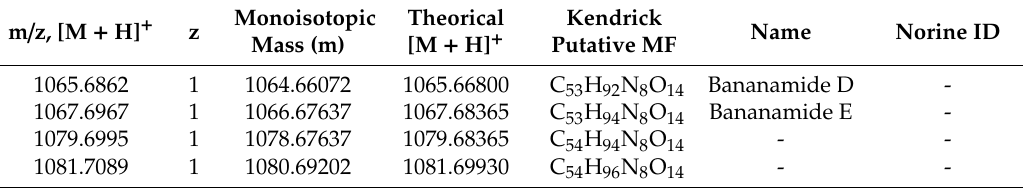
Table 1. [M + H] + values extracted from HRMS-spectrum and their corresponding molecular formula (MF) assigns using Kendrick Formula Predictor (https: // bioinfo.cristal.univ-lille.fr / kendrick-webapp / ). Monoisotopic Theorical Kendrick m / z, [M + H] + z Name Norine ID Mass (m) [M + H] + Putative MF 1065.6862 1 1064.66072 - 1067.6967 1 1066.67637 - 1079.6995 1 1078.67637 - 1081.7089 1 1080.69202 -